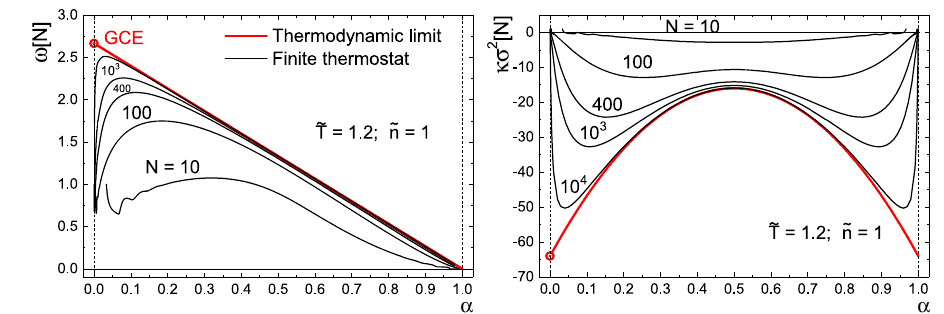
Figure 1. Scaled variance (left) and kurtosis (right) of particle number (conserved charge) fluctuations as functions of the parameter α . The red lines are obtained from the SAM formulas (3). The black lines represent the numeric results calculated explicitly from the vdW partition function [12] using Eq. (2) for di ff erent values of the total number of particles in the system N 0 . The red dots at α = 0 represent GCE values [13]. Taken from